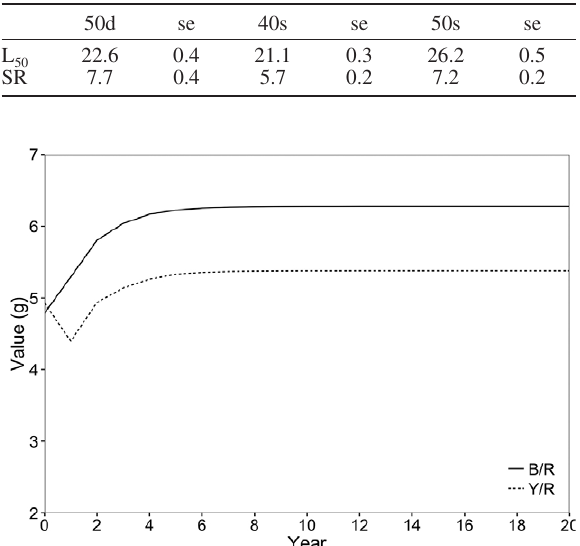
Fig. 6. – Simultated effects on the yield per recruit (Y/R, dotted line) and biomass per recruit (B/R, black line) in the red shrimp fishery after shifting mesh configuration from 40-mm square mesh to 50- mm square mesh. The y-axis represents the values in grams of yield per recruit and biomass per